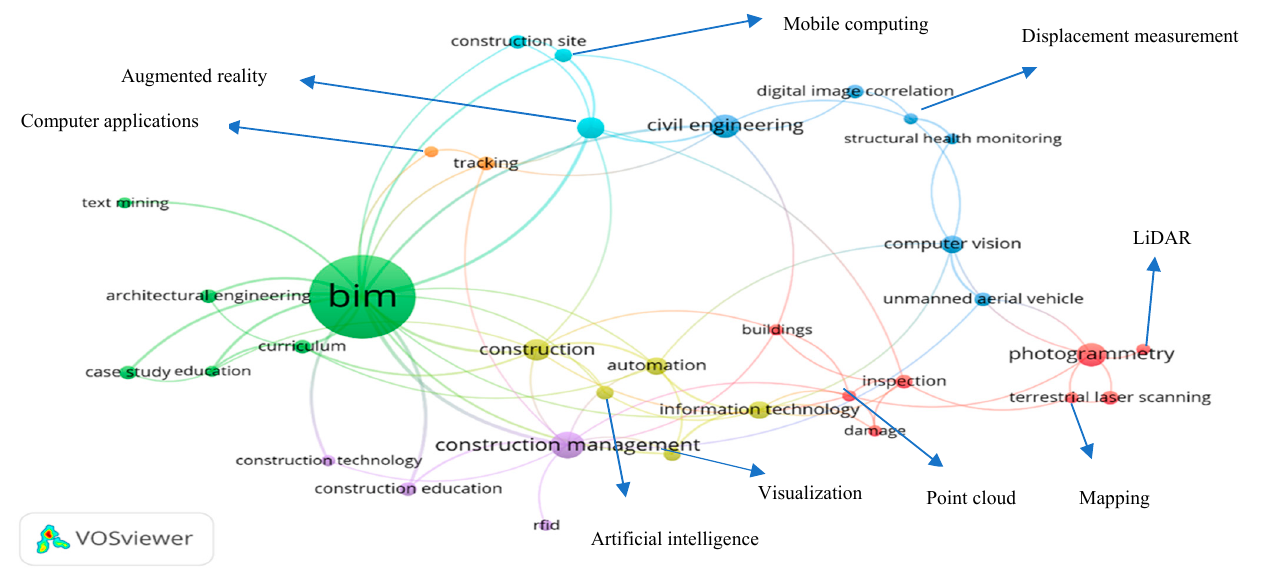
Figure 5. Research interests on DTs in the AEC industry (keywords co-occurrence) .